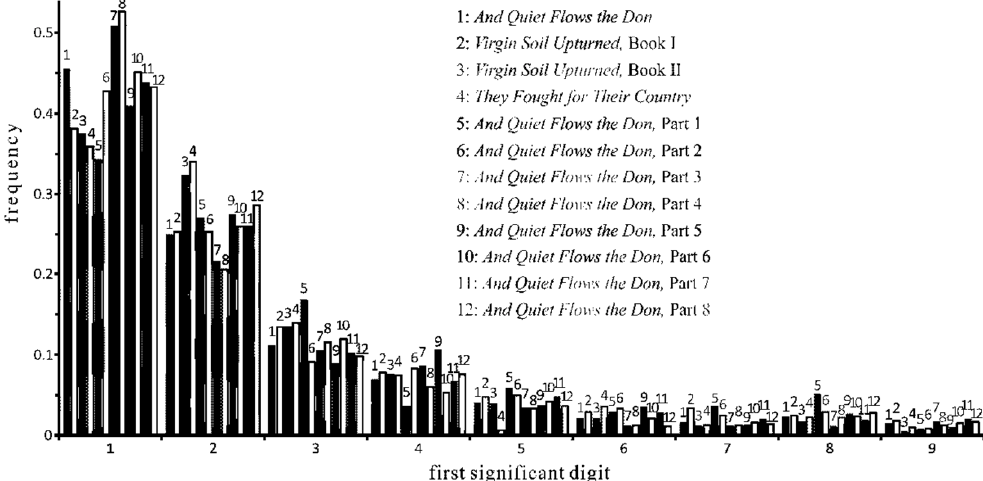
Figure 9. Distribution of the first significant digits of numerals in the novels And Quiet Flows the Don , Virgin Soil Upturned , They Fought for Their Country .